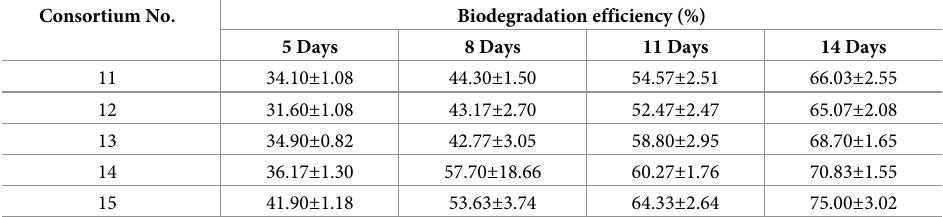
Table 13. Effects of biodegradation time on crude oil degradation efficiency of 5 fungal consortia. Consortium